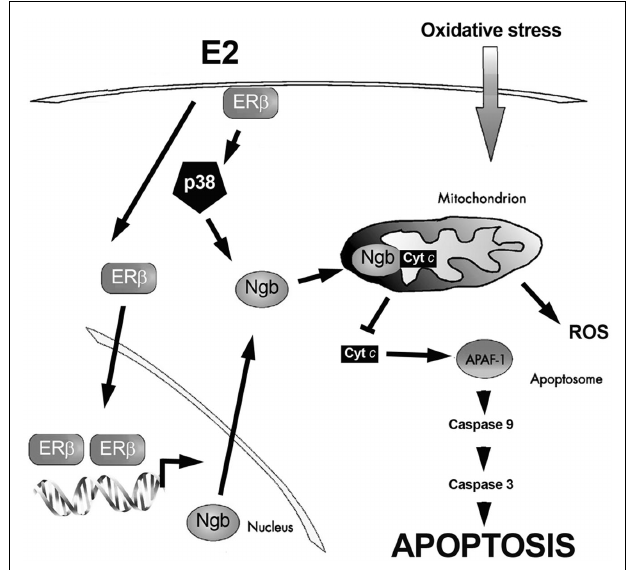
FIGURE 2 | Schematic model illustrating the ER β -dependent E2-induced neuroprotection against oxidative stress. Exposure to oxidative stress induces cytochrome c (cyt c ) release into the cytoplasm. Once in the cytosol cyt c mediates the activation of the adaptor molecule apoptosis–protease activating factor-1 (Apaf-1), generating the apoptosome. Apoptosome can recruit caspase-9 favoring proteinase activation.These events induce the catalytic maturation of caspase-3, which mediates the biochemical and morphological features of apoptosis. E2, via the synergy between extranuclear and nuclear ER β activities, increases neuroglobin (Ngb) levels, reallocates Ngb at mitochondria, facilitates Ngb-cytochrome c interaction, and prevents apoptosome formation. For details, see